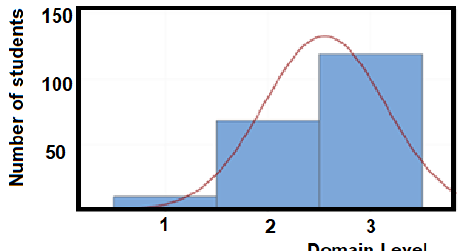
Figure 8. Graph of the domain level for the EFR competency. Mean = 2.55, standard deviation = 0.59 and 95% confidence interval for mean (2.47:2.63).